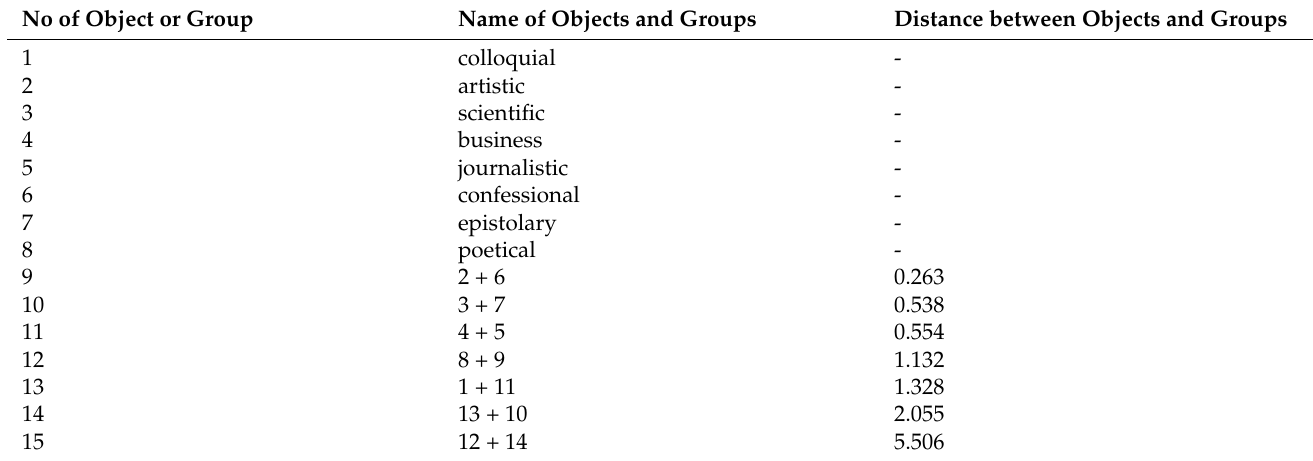
Table 5. The results of cluster